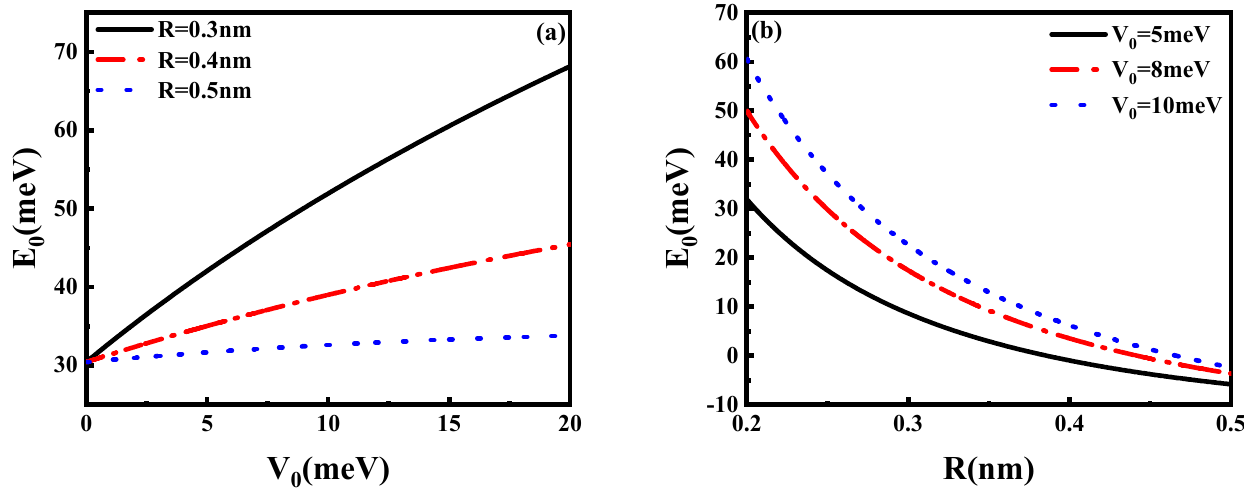
versus ( a ) AGCP barrier height V (cid:2868)